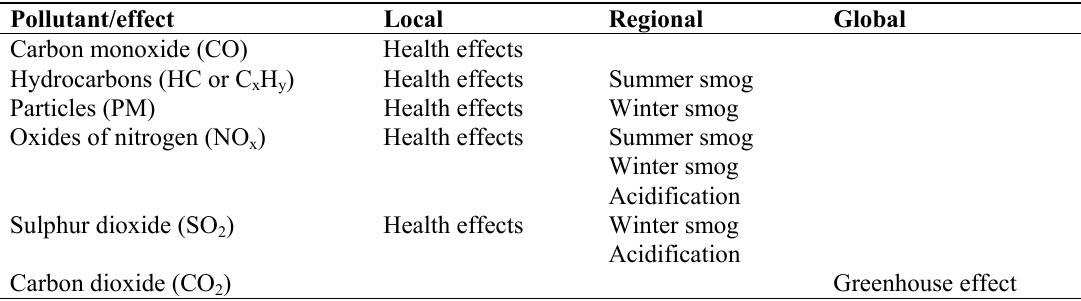
Table 1: Air pollution and geographical